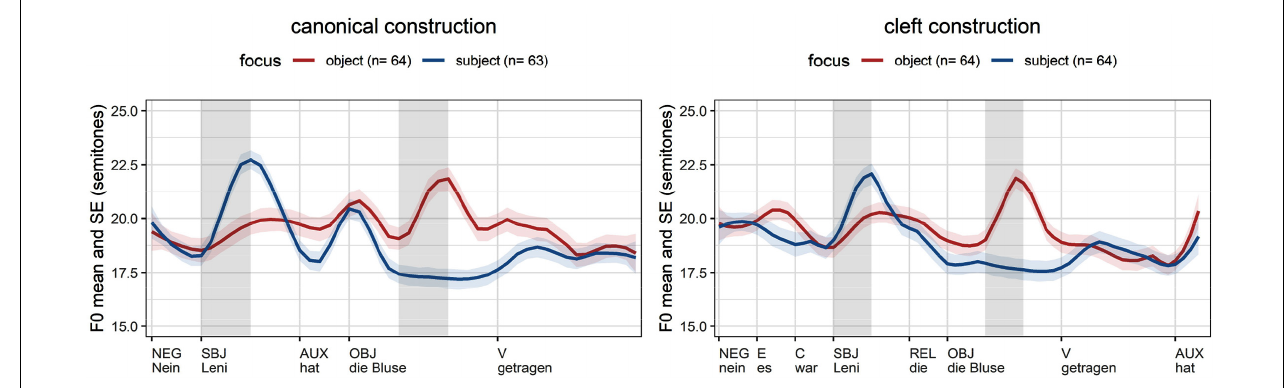
FIGURE 3 | Average f o measurements in German (time normalization based on five equal intervals per syllable; vertical lines: word edges; gray cells: areas of interest, stressed syllable of subject and object).